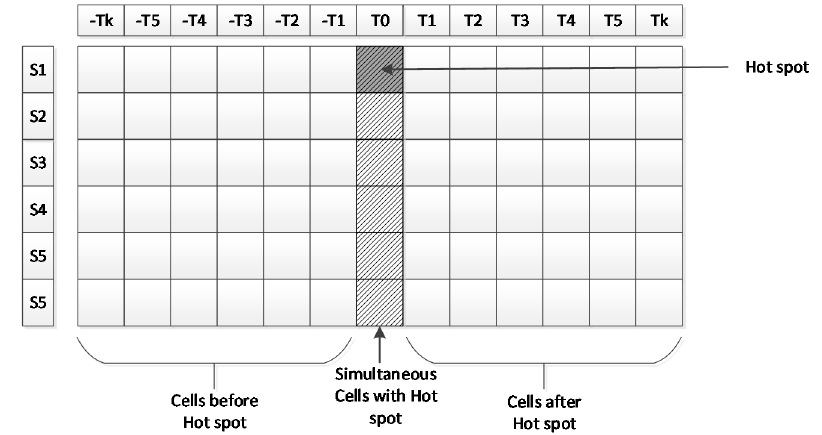
Figure 2. Diagram of temporal expanded near-repeat algorithm.